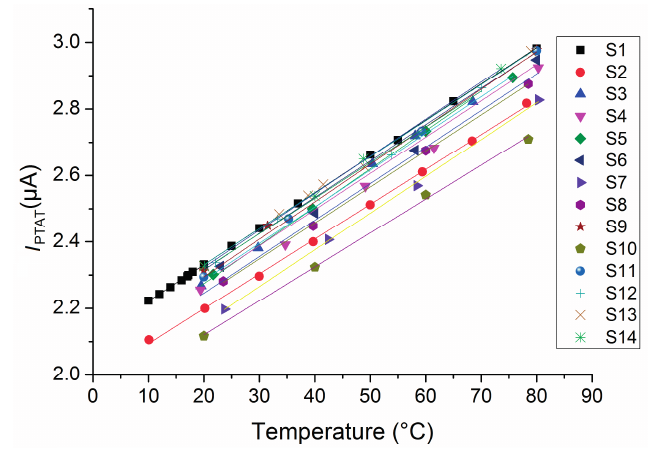
Figure 10. Measured PTAT currents versus temperature.